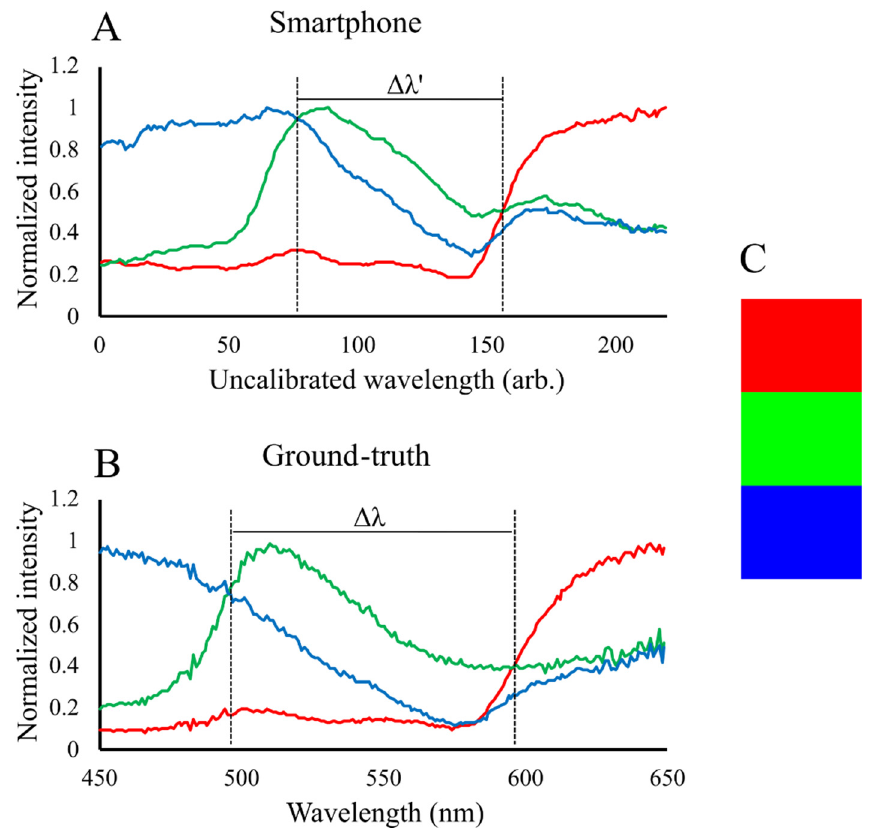
Figure 8. ( A ) An uncalibrated spectral reflectance plot of from the uncalibrated data cube for three x–y points corresponding to the red, green, and blue parts of the spectral calibration reference target. ( B ) The ground-truth reflection spectrum for each colour of the spectral calibration reference target measured using a Thorlabs CCD spectrometer. The similarity between the two enabled points to be selected as known wavelength calibration points (highlighted with vertical dotted lines). ( C ) shows the spectral calibration reference target.